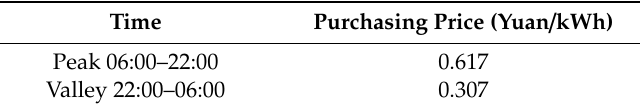
Table 2. Peak / Valley residential electricity price.